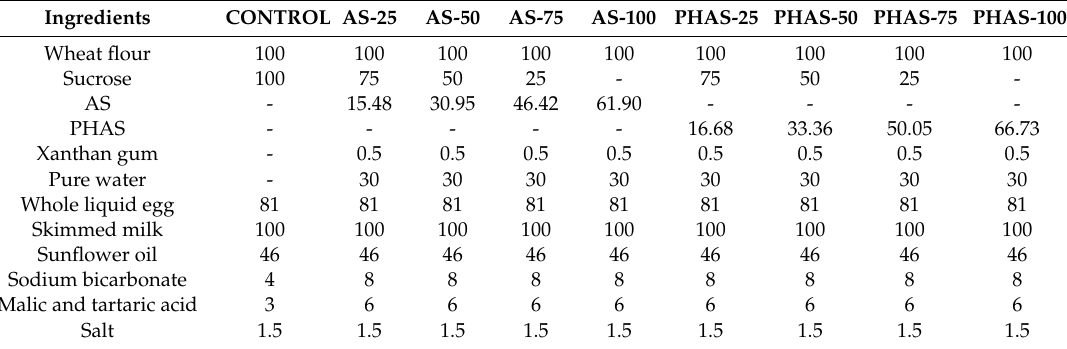
Table 1. Formulations of the di ff erent mu ffi n batters (percentage on wheat flour